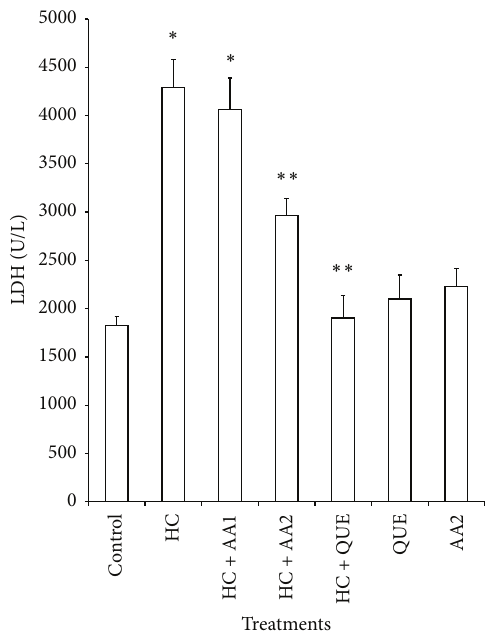
Figure 3: Effects of methanol extract of Artocarpus artilis on the activities of serum lactate dehydrogenase (LDH) of hypercholes- terolemic rats. ∗ Significantly different from control ( 𝑃 < 0.05 ), ∗∗ significantly different from HC ( 𝑃 < 0.05 ). HC: hypercholes- terolemic rats, AA1: Artocarpus altilis at 100 mg/kg, AA2: Artocarpus altilis at 200 mg/kg, and QUE: Questran at 0.26 g/kg.